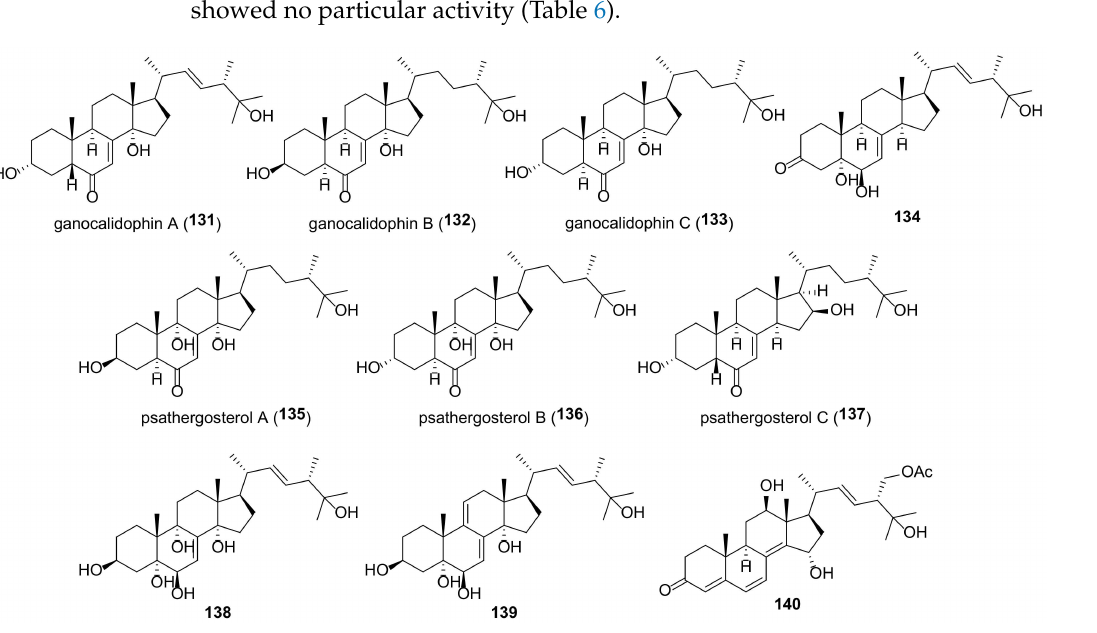
Figure 15. Structures of fungal 25-hydroxy